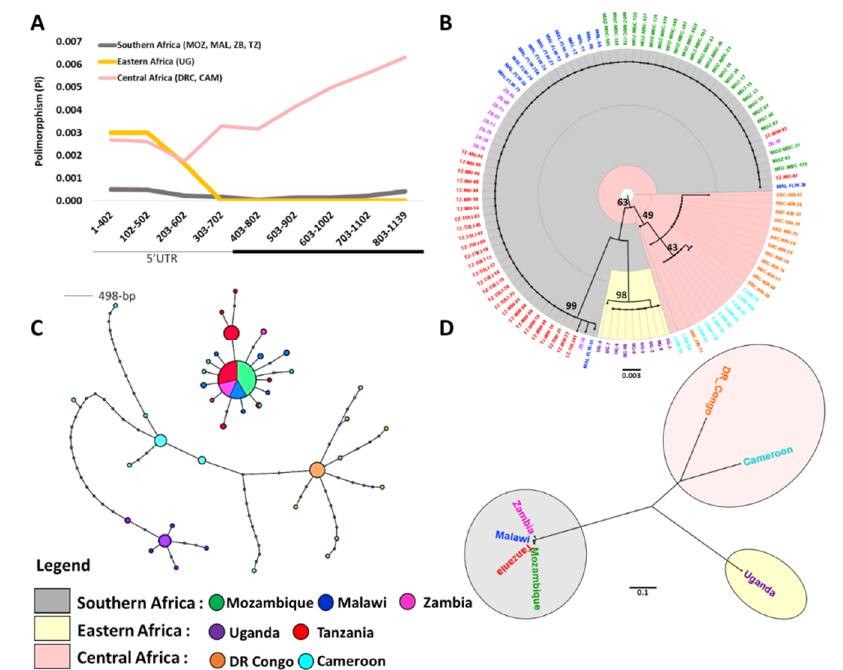
Figure 2. Analysis of genetic diversity in CYP6P9a key pyrethroid resistance gene in An. funestus populations across seven di ff erent African countries. ( A ) Sliding-window analysis of nucleotide polymorphism (Pi) in Southern Africa (158 accessions), Eastern (46 accession) and Central Africa (18 accessions). Pi was calculated for segments of 400 bp at 100 bp intervals. The black bar shows CYP6P9a gene’s exon. ( B ) Maximum likelihood tree of the CYP6P9a gene sampled from throughout Africa, showing clear geographical divergence between southern Africa (MZ, MAL, ZB and TZ; 99% bootstrap support), East Africa (UG; 98% bootstrap support) and Central Africa (DRC and CAM; 49% bootstrap support). ( C ) Haplotype network for non-synonymous nucleotide variants in CYP6P9a. Mosquito populations from MOZ, MAL, ZB and TZ form a defined clade from UG, DRC and CAM populations, and are dominated by a single Major haplotype. UG forms a distinct haplotype related to CAM and DRC populations that also form two distinct but related haplotypes. Haplotypes are labelled by colour and shape where the area of each circle is proportional to the frequency of the haplotype it represents. Lines connecting haplotypes and each node represent a single mutation. ( D ) Phylogenetic tree generated by the Neighbor-Joining method based on pairwise F st distance obtained from 1139-bp CYP6P9a gene, including 111 A. funestus sequences from seven African countries according to each sample’s country of origin.